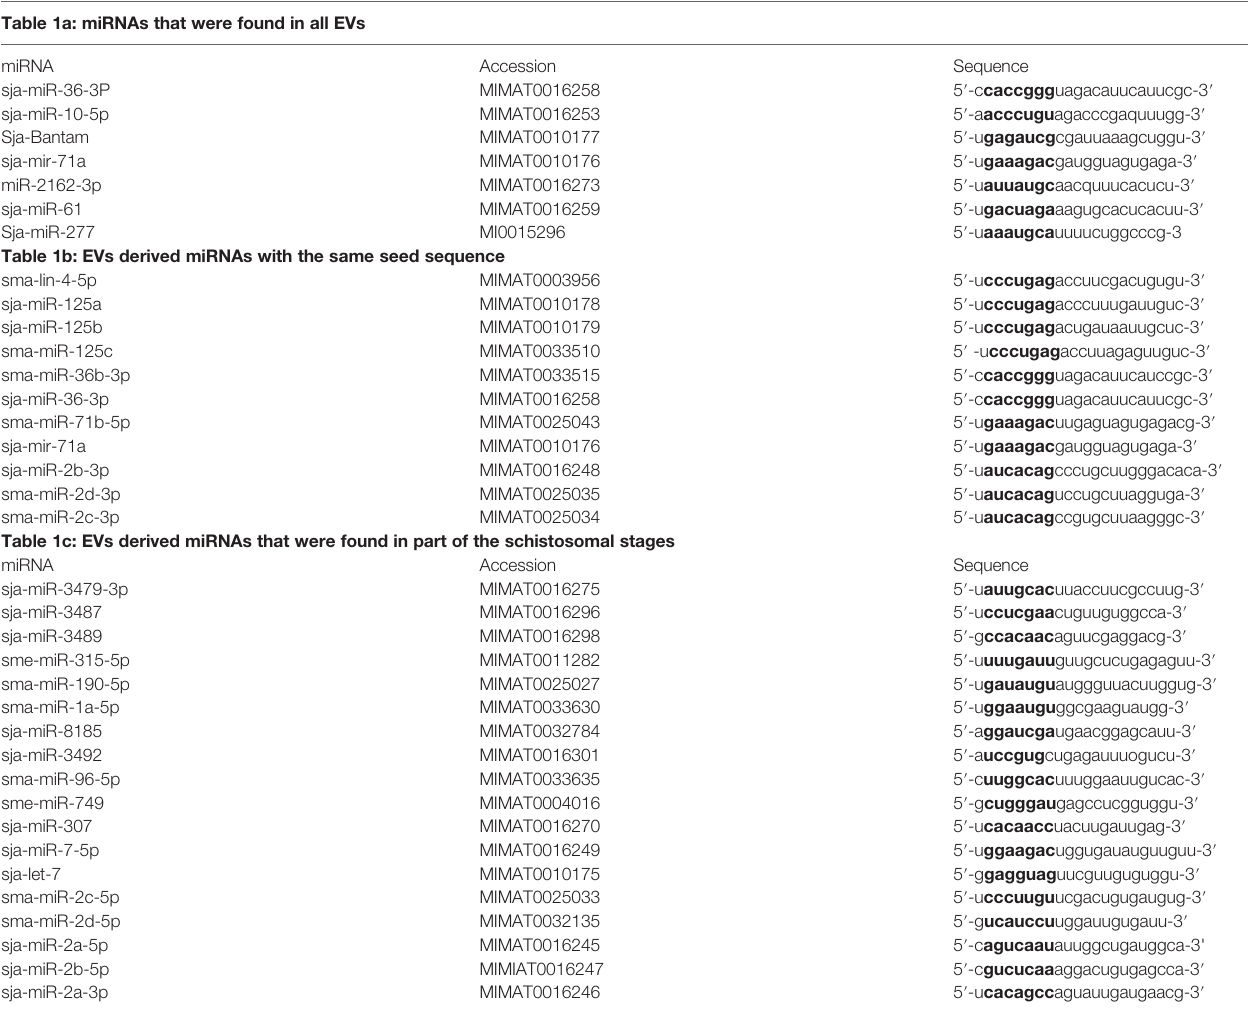
TABLE 1 | Sequences of miRNAs from schistosomal EVs that were taken from the miRBase. Table 1a: miRNAs that were found in all EVs